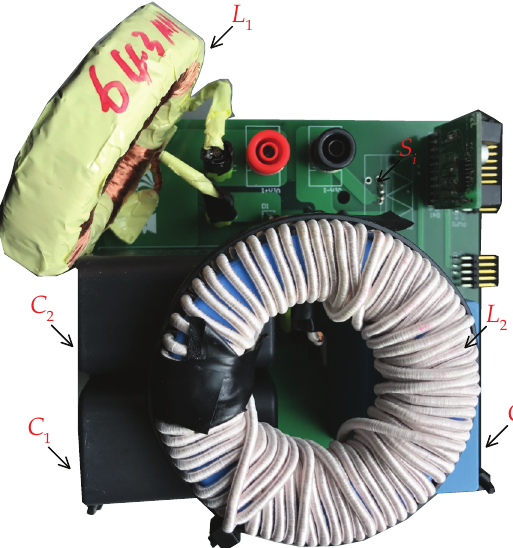
Figure 11. Photograph of the prototype of the proposed